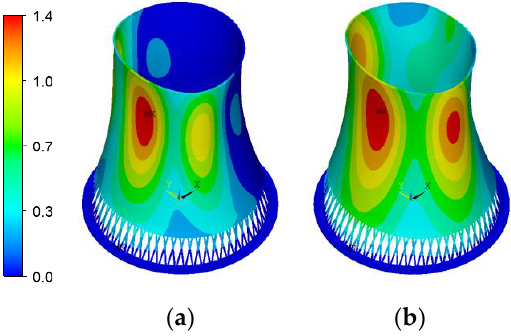
Figure 17. Schematic diagram of the 3D horizontal displacement of towers in two wind fields (units: m). ( a ) Type A wind field. ( b ) Typhoon wind field.